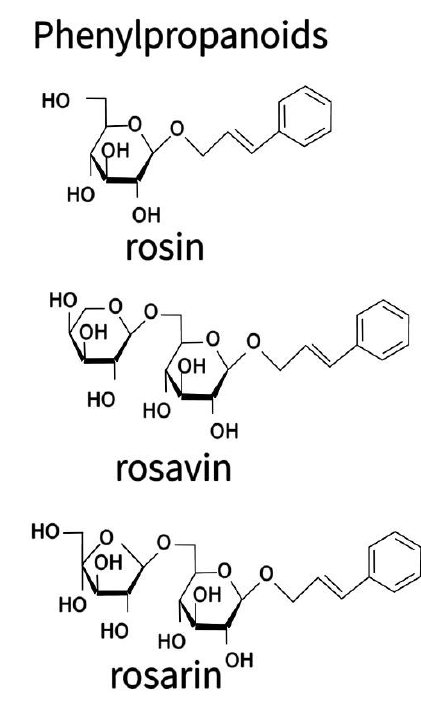
Figure 1. The general metabolites of Rhodiola spp.